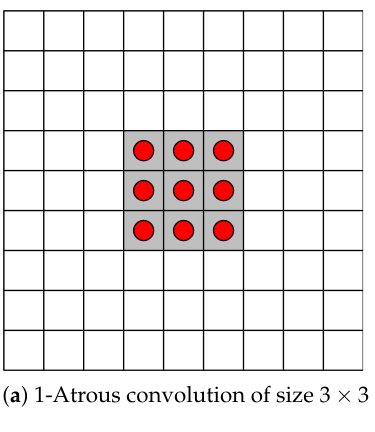
Figure 4. Atrous